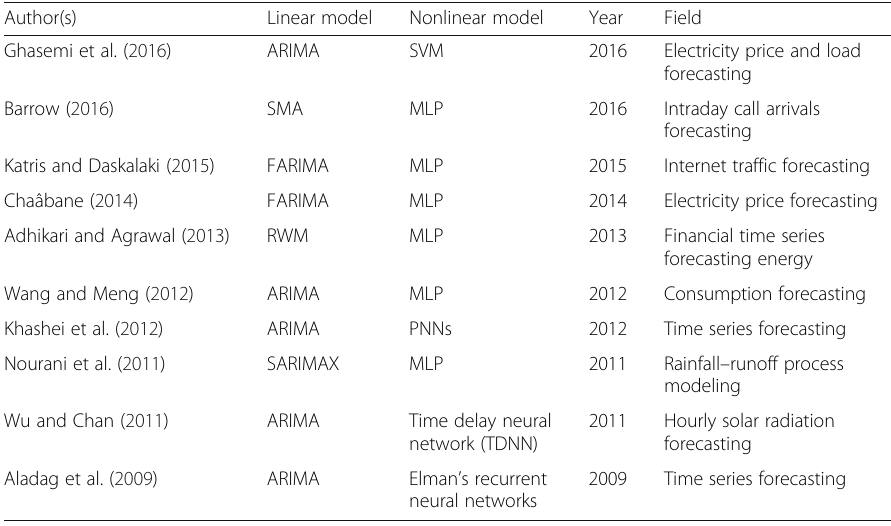
Table 1 Literature on series linear or nonlinear models for time series forecasting